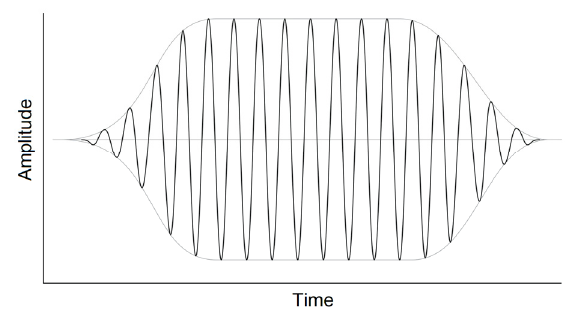
Figure 7. Characteristic shape of the emitted pulse.